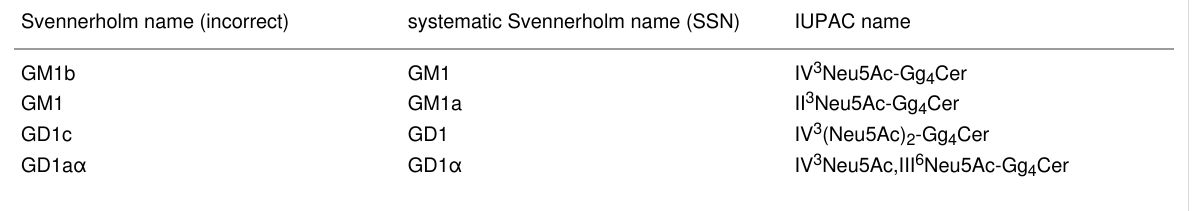
Table 3: Commonly used Svennerholm names that differ from their systematic counterparts. Svennerholm name